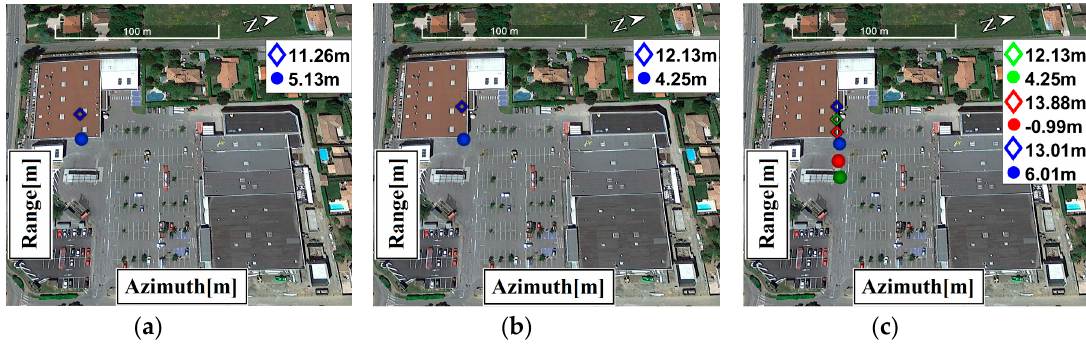
Figure 8. The double scatterers detected by Fast-Sup-GLRT in the dual polarization case, and their estimated heights, along the three range lines A (a), B (b), C (c).